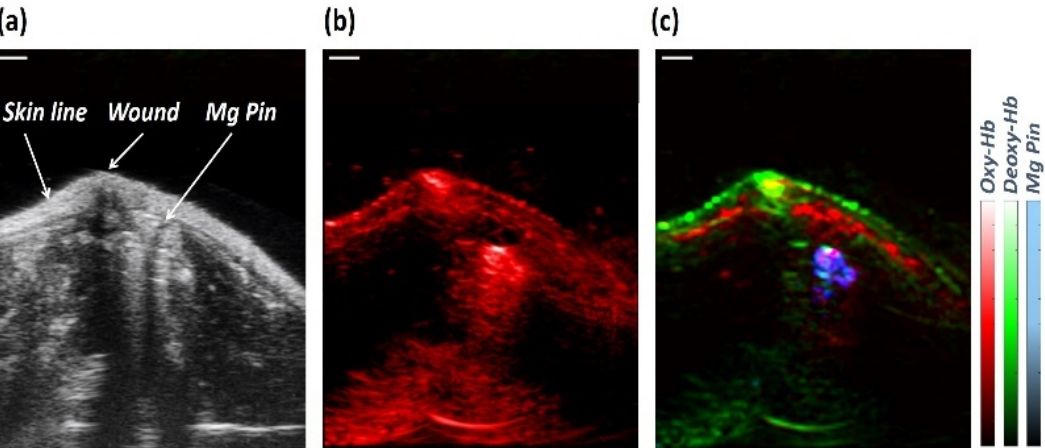
Figure 6. ( a , b ) The Ultrasound and Photoacoustic images of the Mg-implanted rat’s femur on day 3 after surgery in grey and red scales, respectively; ( c ) Overlapped unmixed distribution maps of the Oxy-, Deoxy-hemoglobin, and Mg pin in red, green, and blue scales, respectively, automatically obtained from sPAI. The scale bar size is 2 mm.